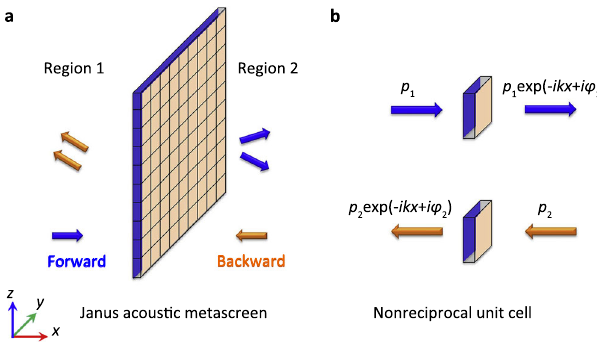
Fig. 1 Concept of Janus acoustic metascreen. a Schematic diagram of the Janus acoustic metascreen. b Schematic diagram of the nonreciprocal phase modulating unit cell. The blue and orange arrows indicate the forward and backward